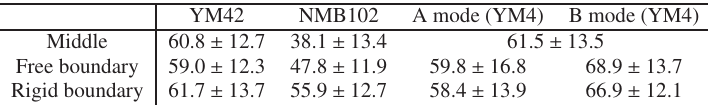
Table 1 Average (Ave.) and standard deviation (S. D.) of swimming speed ( µ m /